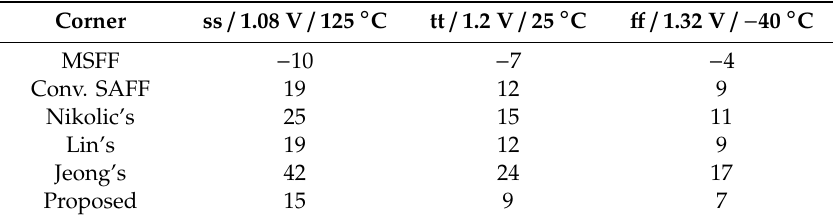
Table 5. Hold time (ps) of the flip-flops across PVT corners.